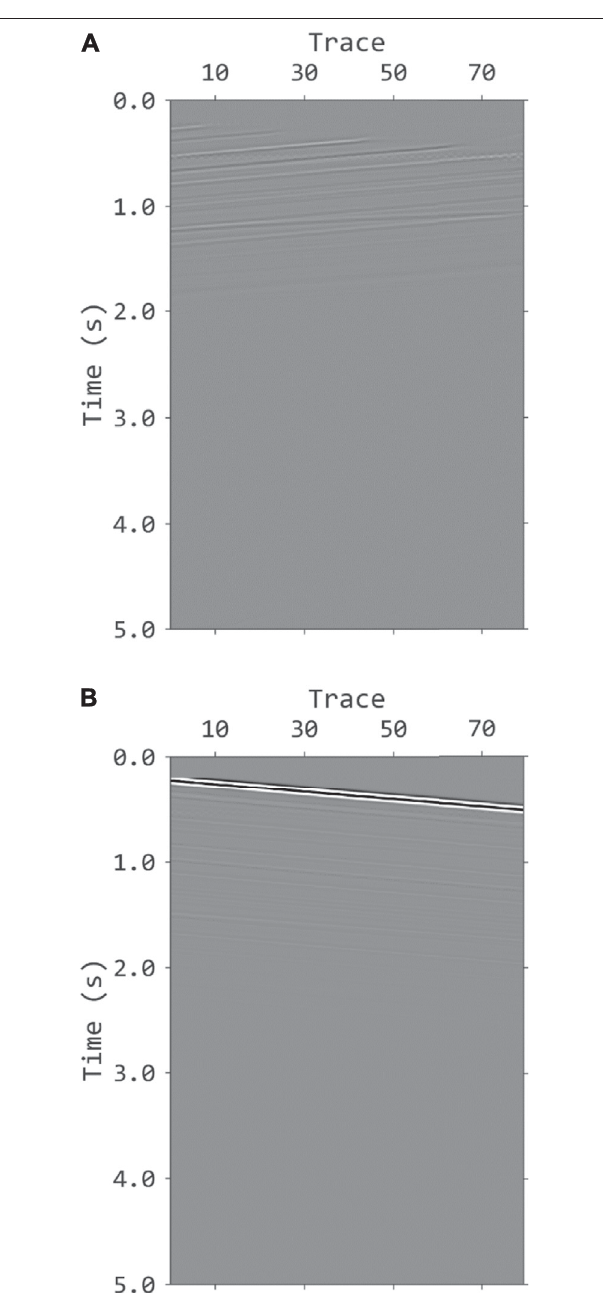
FIGURE 4 | The separated components of the data shown in Panel 3 after f-k fi ltering. (A) The upgoing components of the data generated without free surface, it is the primaries in the original data. (B) The downgoing components of the data modeled with free surface, containing direct waves and free-surface – related multiples.